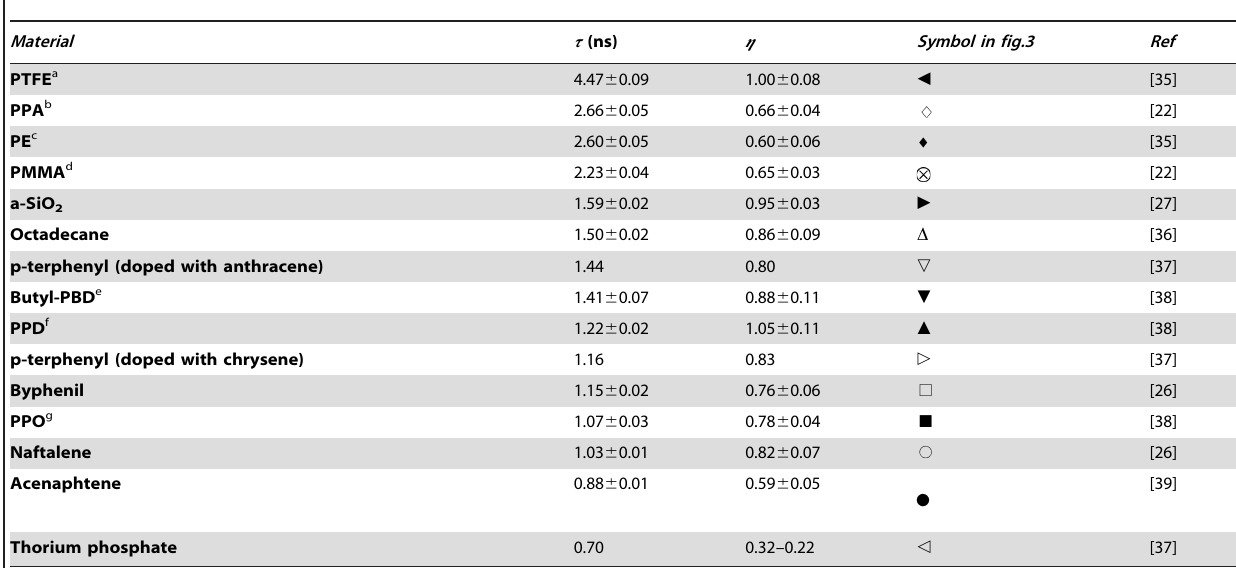
Table 1. Relative contact density g and o -Ps lifetime t in some molecular solids and polymers.